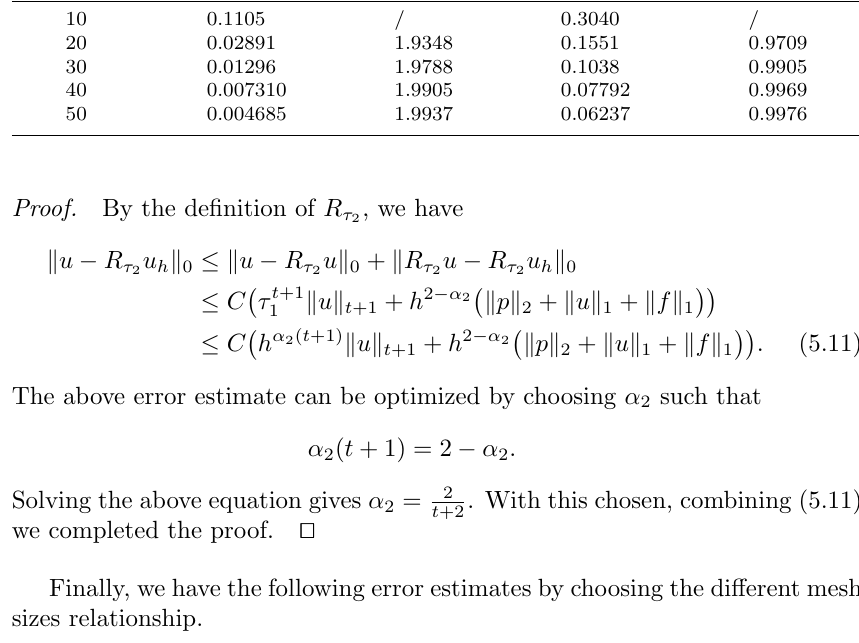
Table 1. The results of standard finite volume method with P 1 element. 1